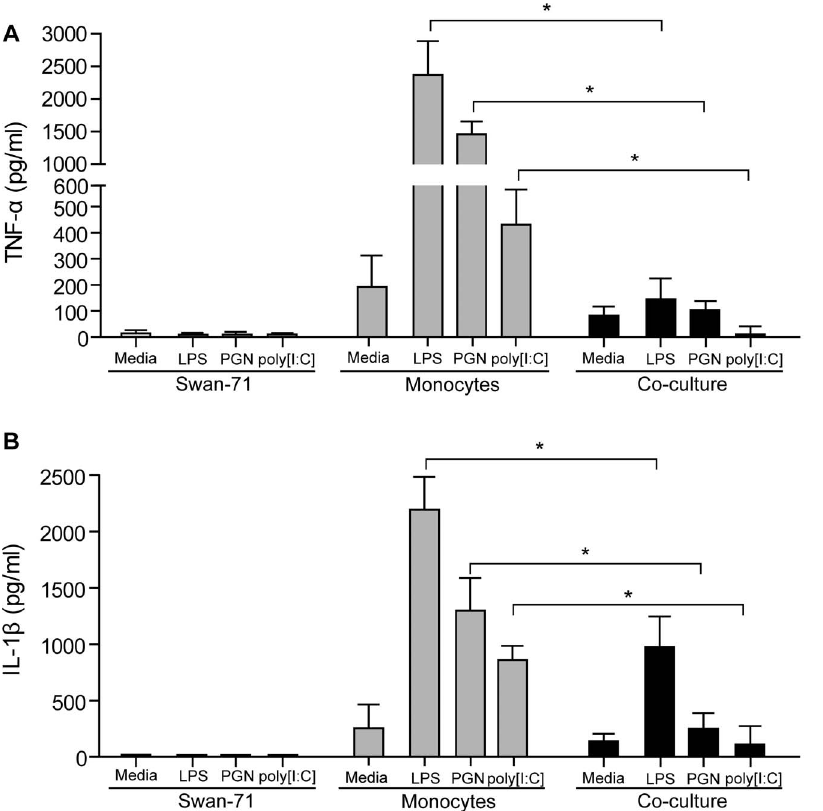
Figure 2. Trophoblast cells prevent inflammatory cytokine release by CD14 + cells under PAMP stimulation. Maternal monocytes were co-cultured or not with Swan-71 cells in the absence or presence of LPS (10 m g/ml), PGN (10 m g/ml), or poly [I:C] (10 m g/ml). After 24 hours supernatants were collected to quantify TNF- a ( A ) and IL-1 b ( B ) by ELISA. Results are expressed as mean 6 SEM pg/ml from 3 independent experiments (*p , 0.05 Wilcoxon